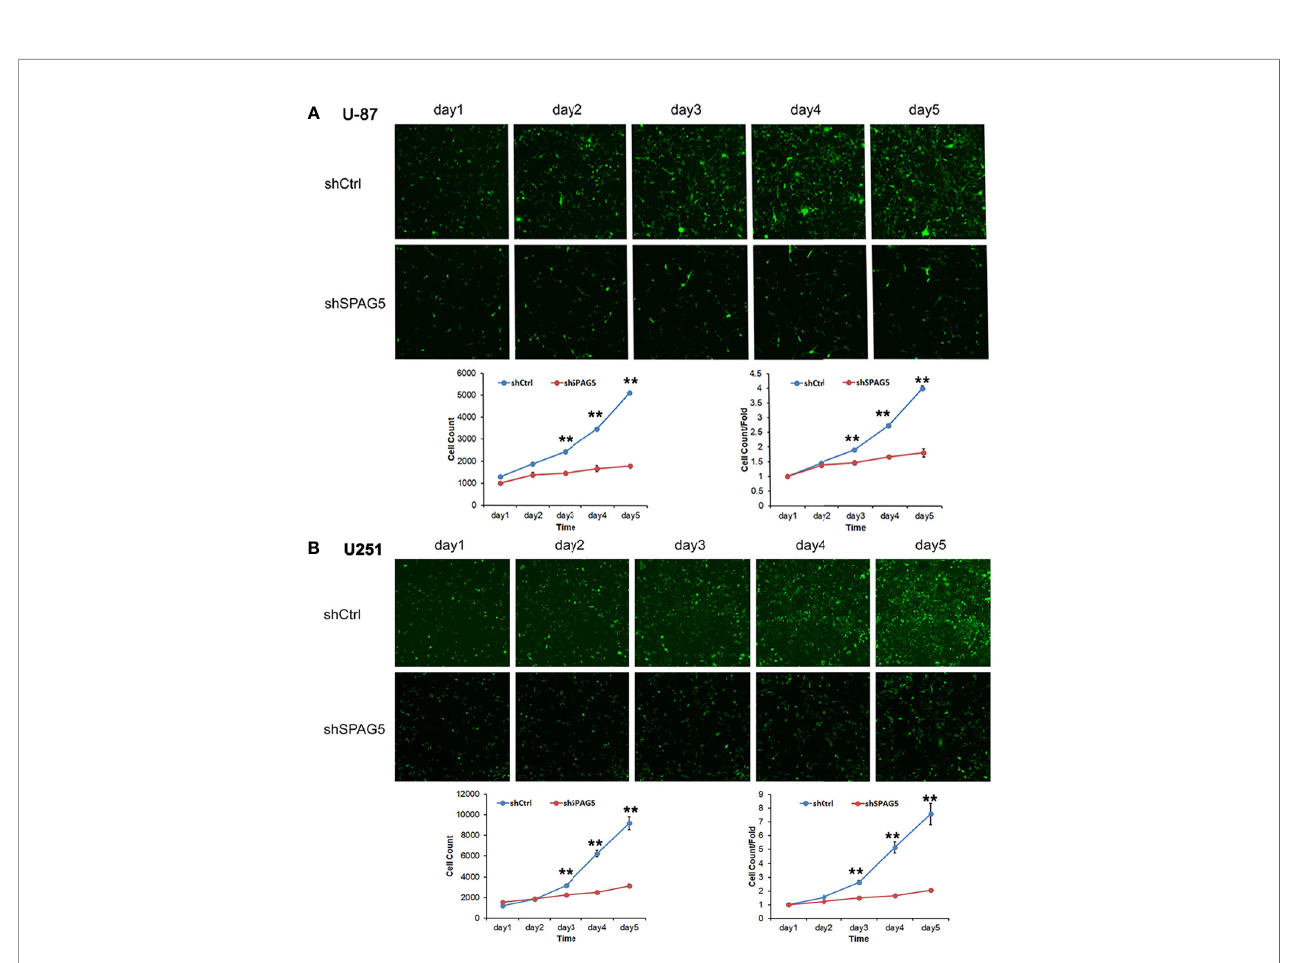
FIGURE 3 | The proliferation capacities were detected by Celigo cytometry system in (A) U-87 cells and (B) U251 cells transfected with SPAG5-shRNA. Results were expressed as mean ± SD from three independent experiments. vs shCtrl group, ** P <